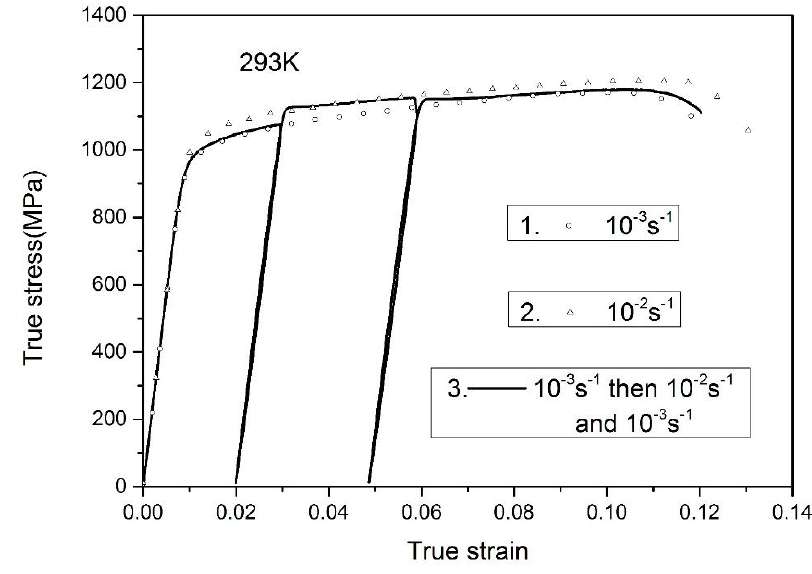
Figure 5. Results under variable strain rates from 10 − 3 s − 1 to 10 − 2 s − 1 , followed by 10 − 3 s − 1 .